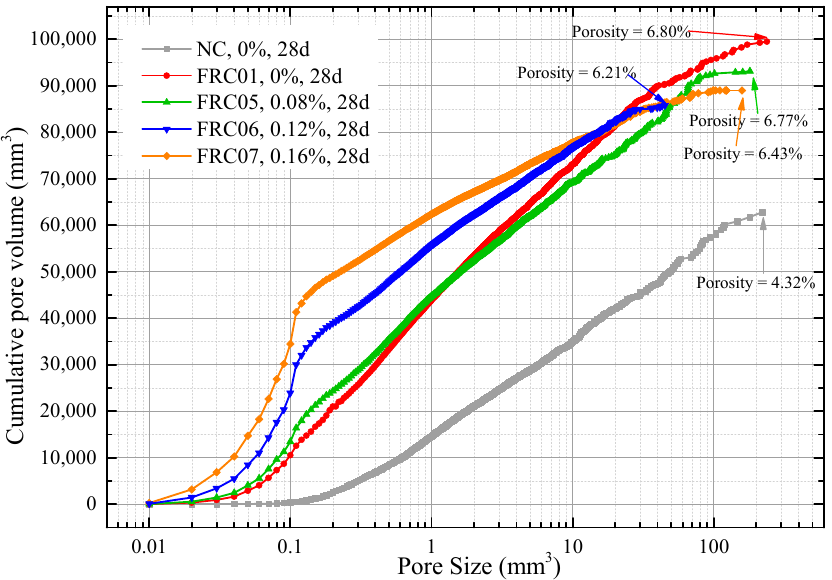
ff erent sizes from ICT images porosity Figure 21. Pore volume of different sizes from ICT images porosity analysis. Figure 21. Pore volume of di